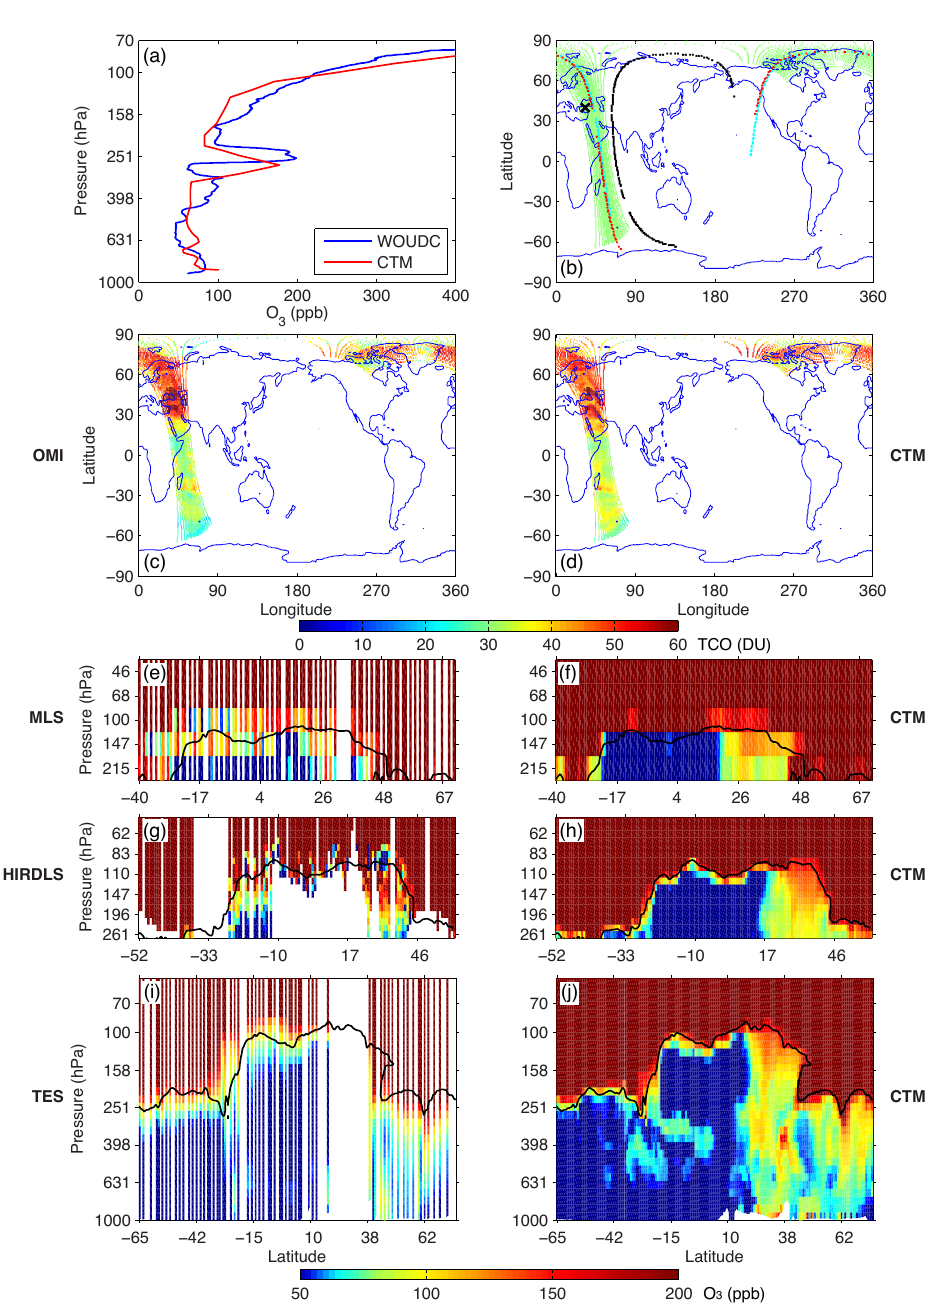
Fig. A3. Same as Fig. A2 for 20 July 2005. The sonde was measured at 11:37UTC, compared with model simulation at 12:00UTC in (a) . The Aura and CTM swaths are for 10:00–11:00UTC. (c) – (j) show the swaths in 0 ◦ –99 ◦